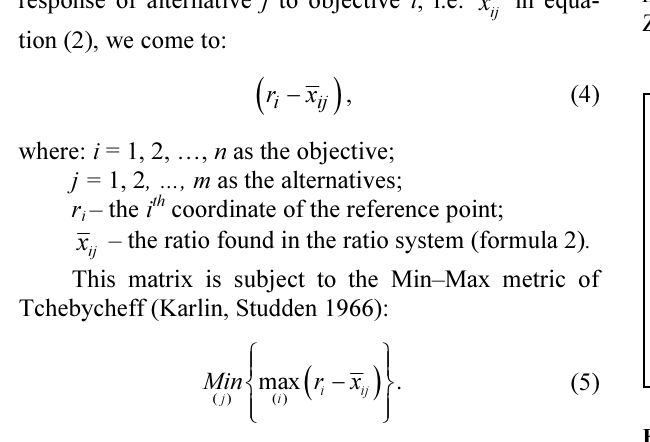
Fig. 7. Diagram of MULTIMOORA Diagram Fig. 7 represents the combination of the three different methods of MULTIMOORA (Brauers, Zavadskas 2011b). Nominal Group Technique: 1) the Ra- tio System; 2) the Reference Point Approach; 3) the Full Multiplicative Form. The Nominal Group Technique and the Delphi method can also be used to reduce the remain- ing subjectivity. Numbers and arrows in the picture are referring by formulas rank and the priority in the multi- objective